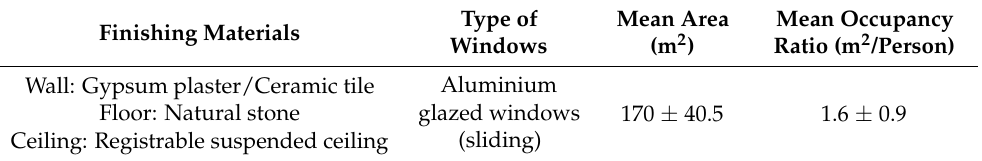
Table 1. Characteristics of the classrooms in the polytechnic building.